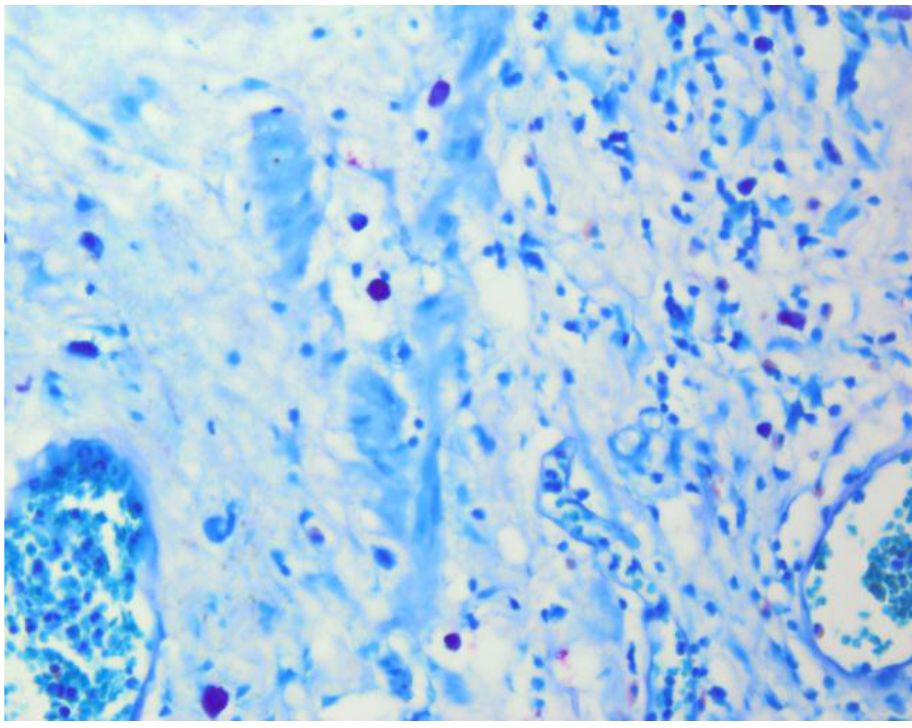
Fig. 3. Giemsa staining for mast cells in